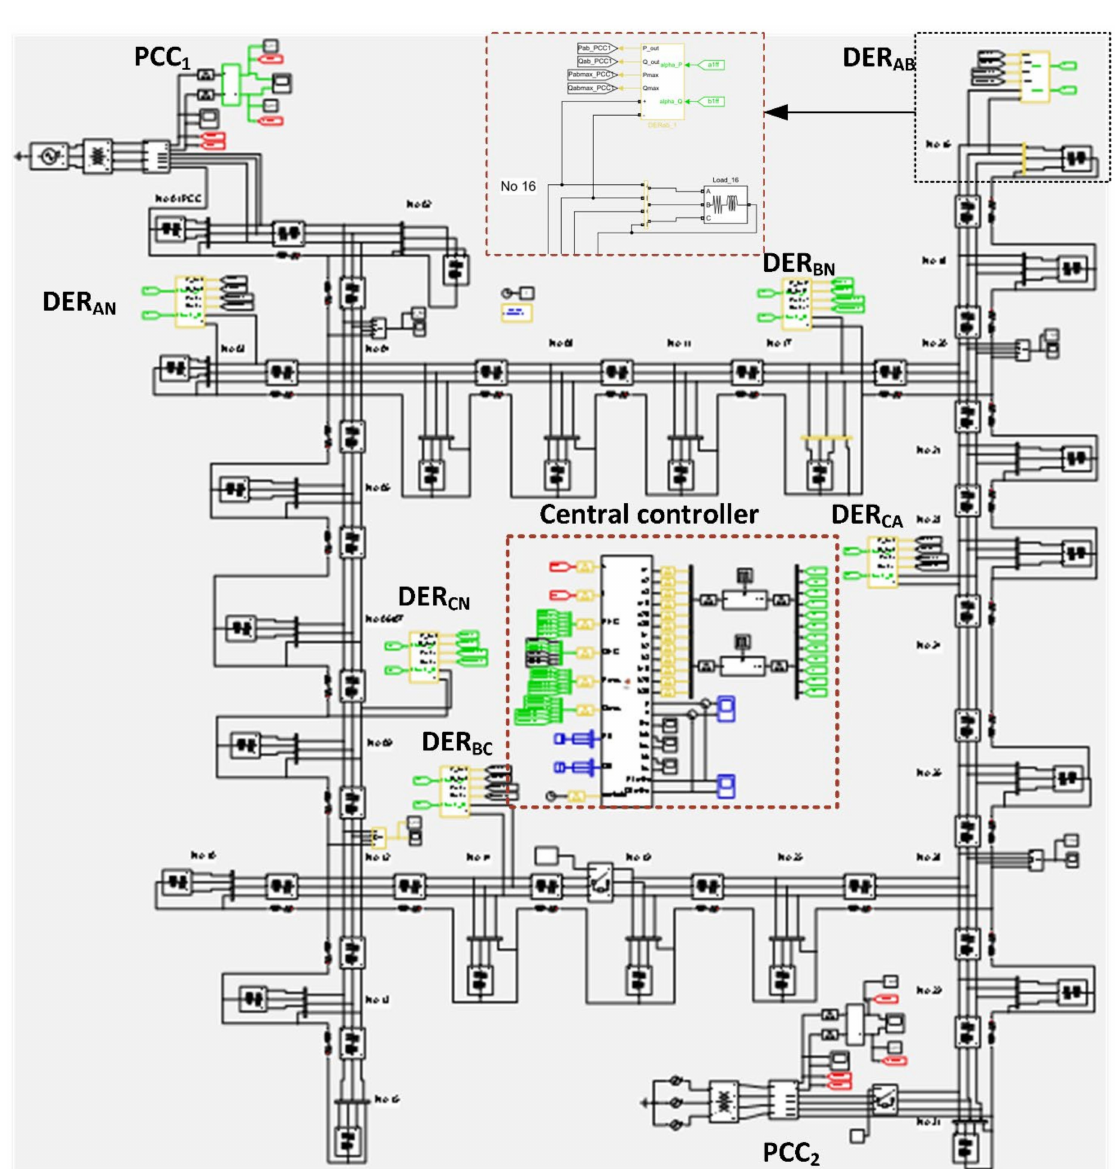
Figure A1. Simulation platform developed at MATLAB/SIMULINK to obtain the